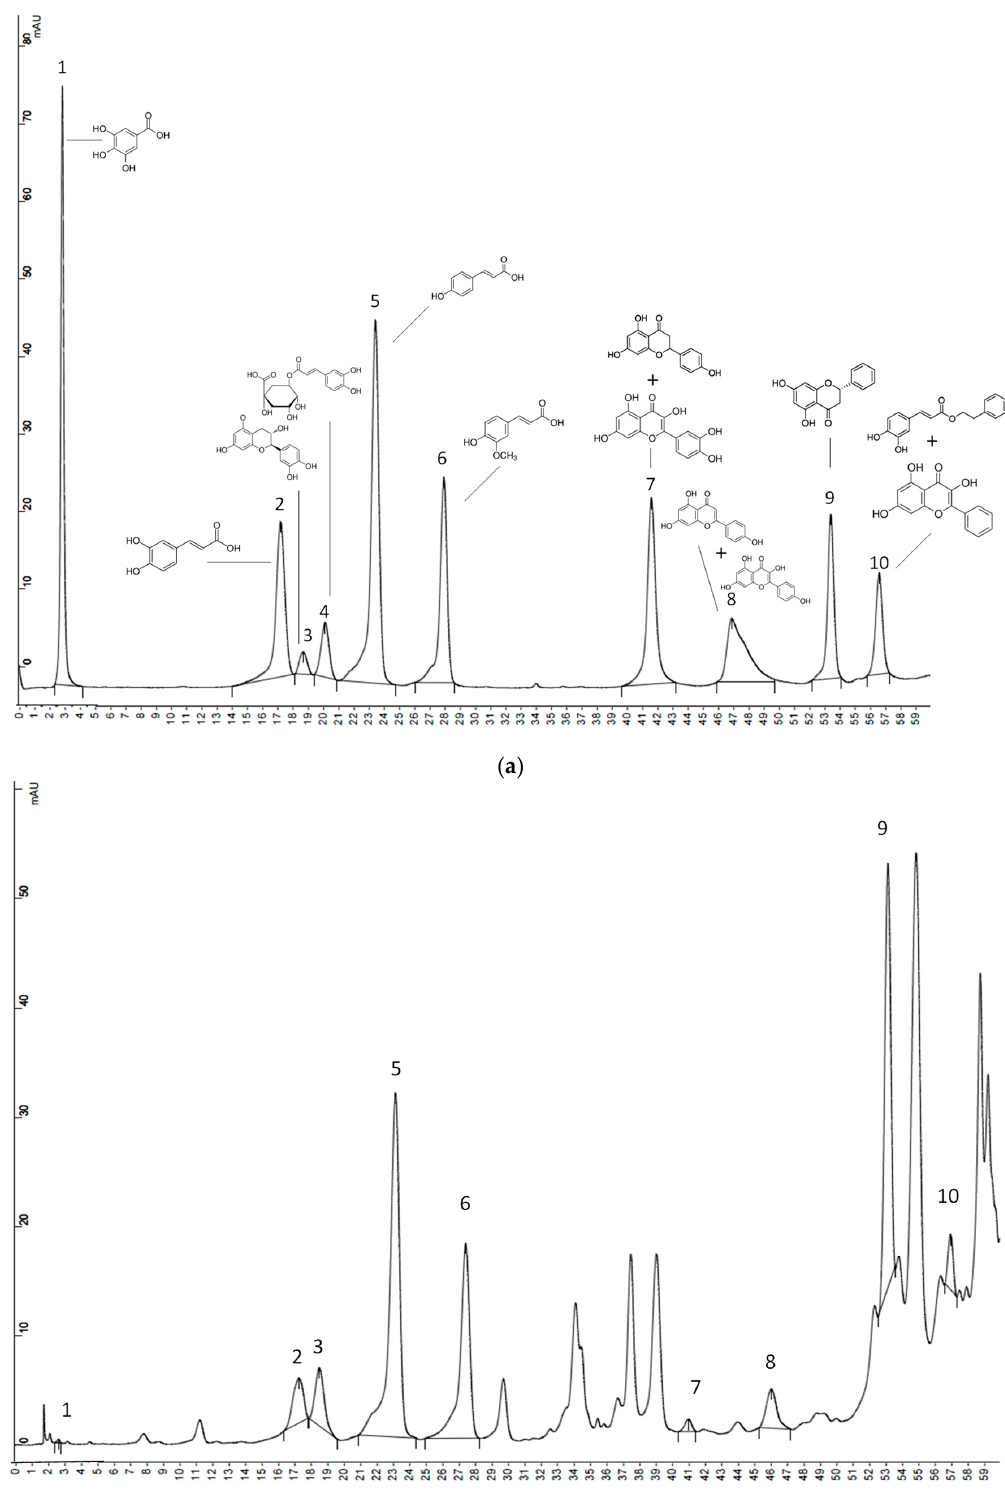
Figure 1. Chromatograms of the standard phenolic compounds ( a ) and NE ‐ Europe propolis sample ( b ) obtained by high performance liquid chromatography ‐ ultraviolet detection (HPLC ‐ UV). Gallic acid (1), caffeic acid (2), catechin (3), chlorogenic acid (4), p ‐ coumaric acid (5), ferulic acid (6), naringenin + quercetin (7), apigenin + kaempferol (8), pinocembrin (9), caffeic acid phenethyl ester (CAPE) + galangin (10).